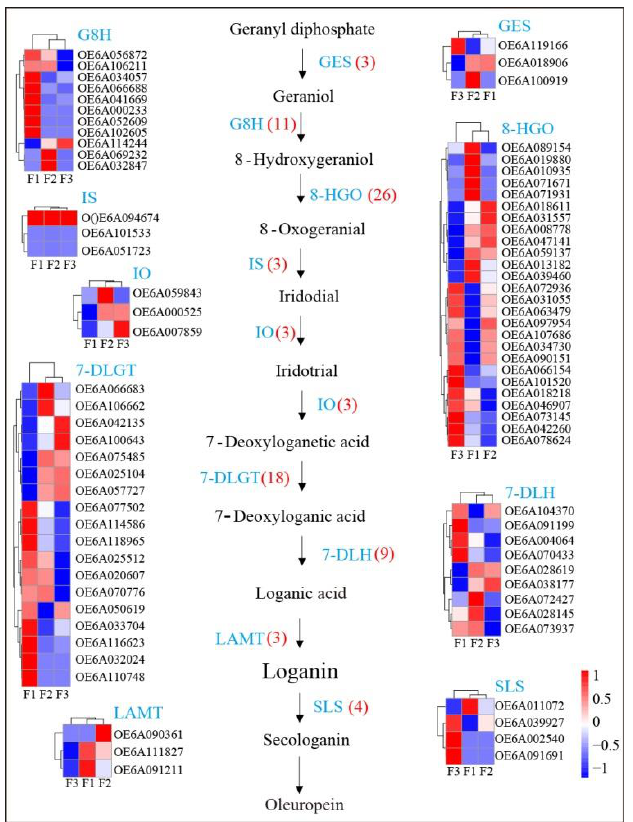
Figure 6. Expression of genes in oleuropein biosynthesis pathways and associated gene expression within olive fruits at different maturity stages. within olive fruits at different maturity